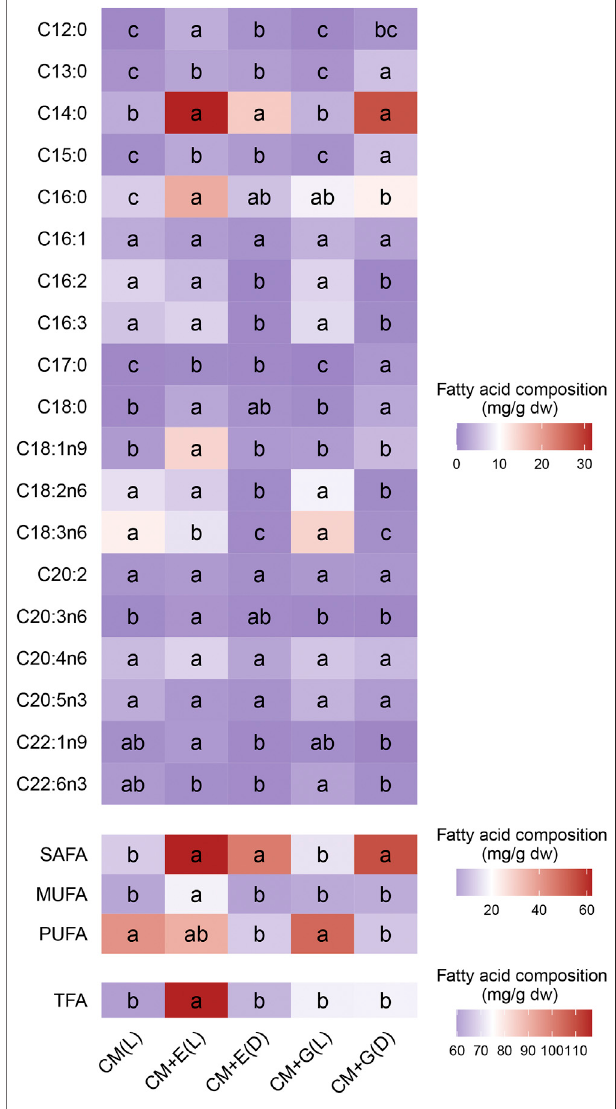
FIGURE 6 | Heatmap of fatty acid composition (mg/g dw) of E. gracilis 815 cultured to Day 6 under different conditions. Different letters indicate signi fi cant difference according to ANOVA test at p ≤